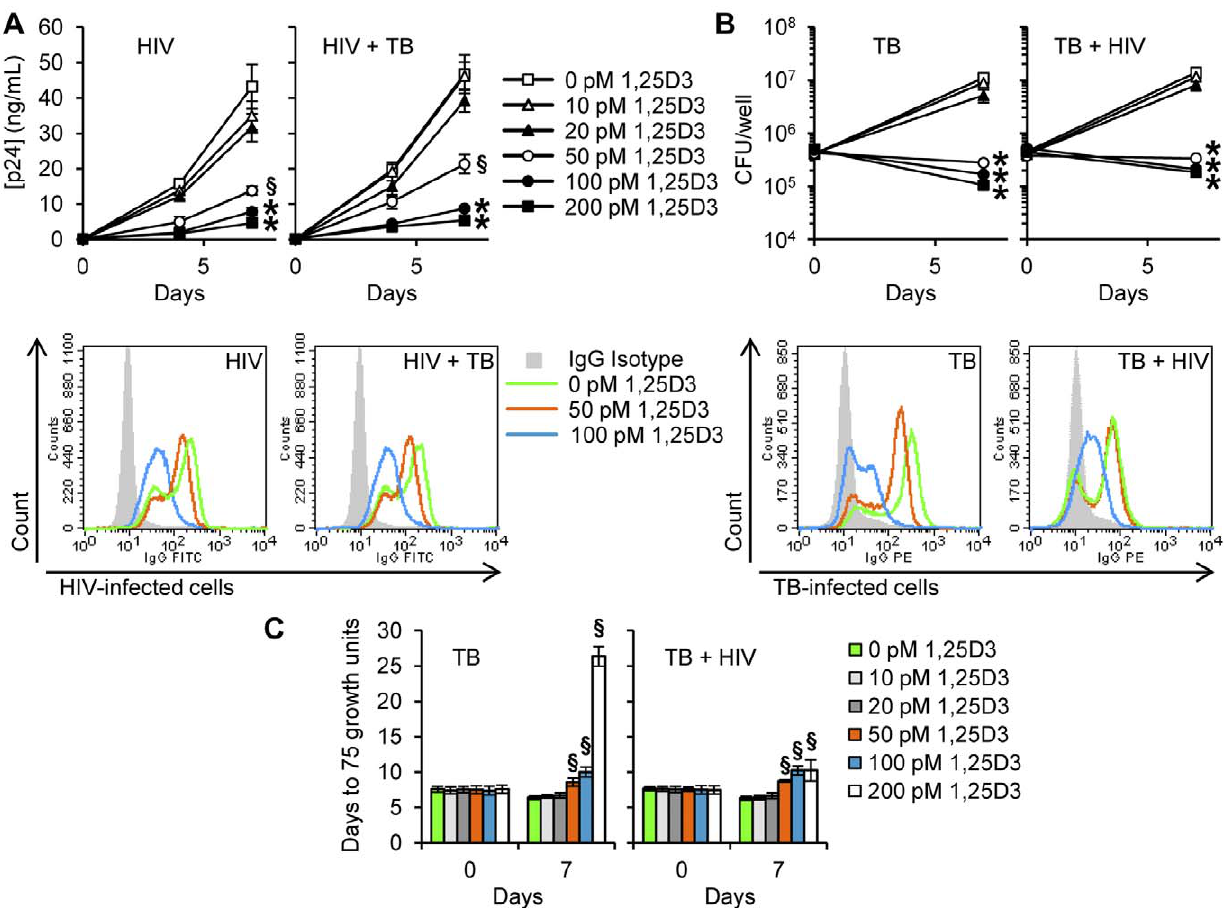
Figure 1. 1,25D3 inhibits HIV and M.tuberculosis replication. MDM were incubated with 1,25D3 for 4 h before infection with HIV and/or M. tuberculosis (TB) for 3 h, washed then incubated with or without 1,25D3 for 7 days. (A) Top, extracellular release of HIV p24 antigen into the cell supernatant at days 0, 4 and 7 was detected by ELISA. Bottom, MDM were harvested and stained for HIV p17. Histograms are shown for a representative donor. (B) Top, cells were lysed after 3 h exposure to infectious agents or at the completion of the infection phase. Intracellular mycobacteria were harvested and assayed for mycobacterial growth at day 0 and day 7. Bottom, MDM were harvested and stained for mycobacterium. Histograms are shown for a representative donor. (C) Cell lysates from panel B were diluted and run in a MGIT 960. Bar and line graphs are reported as mean 6 s.e.m. of three independent experiments performed in triplicate. 1 P , 0.05; * P , 0.001.